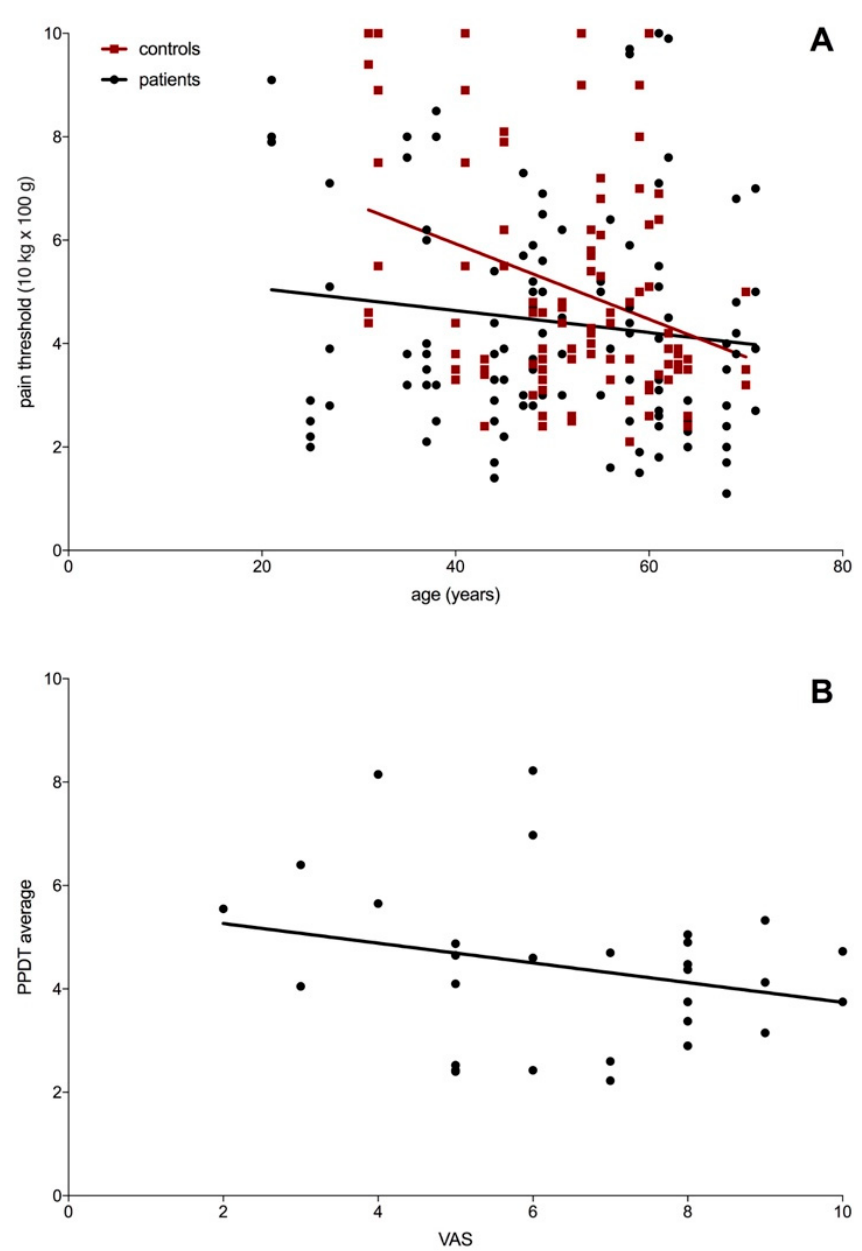
Figure 2. ( A ) Correlation of pressure pain detection threshold (PPDT) with the age of patients (circle) and controls (square). The PPDT decreases in both, patients (n.s., r 2 = 0.1) and controls (p = 0.0010, r 2 = 0.017) with age. ( B ) Correlation of VAS ranking and the PPDT average (n.s., r 2 = 0.065), analysis using linear